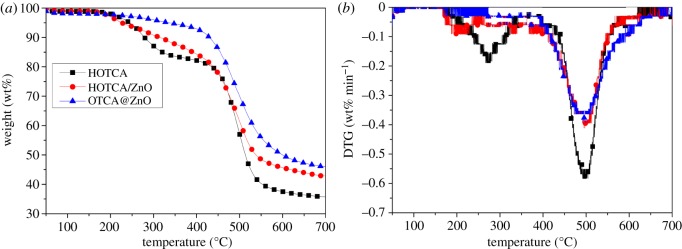
TGA (a) and DTG (b) of HOTCA, HOTCA/ZnO and OTCA@ZnO under N2 atmosphere.